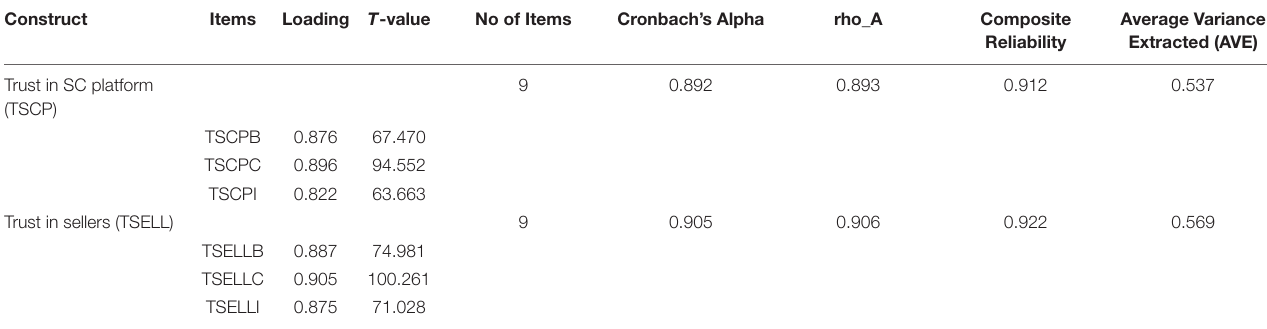
TABLE 5 | High-order construct